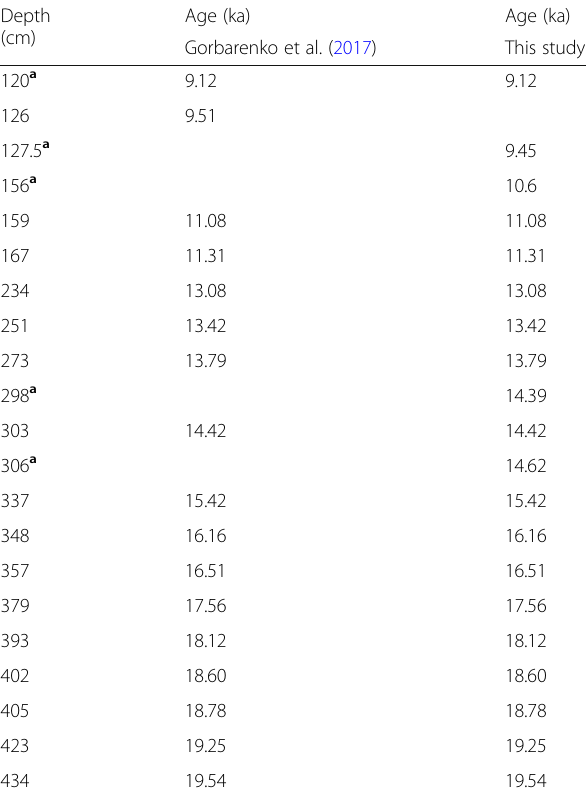
Table 1 Radiocarbon ages and age controlling points used in the Core LV 63-41-2